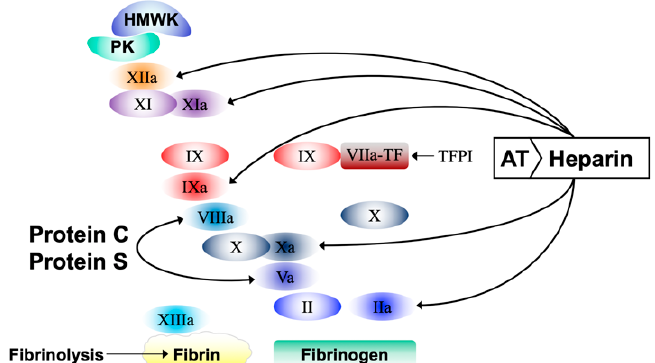
Figure 1. Schematic representation of the iterative coagulation activation starting from the complex TF-FVIIa formation and leading to thrombin (IIa) generation and fibrin formation. Among the other functions (not shown in the scheme), thrombin activates FXI, FXIII, FV, FVIII, and protein C (see also Figure 3). Arrows refer to factors inhibited by the antithrombin–heparin complex or by the activated protein C–protein S complex or TFPI. The suffix “a” denotes activated coagulation factors. HMWK, high molecular weight kininogen; PK, prekallicrein; Roman numbers refer to coagulation factors; TFPI, tissue factor pathway inhibitor; AT, antithrombin; TF, tissue factor.